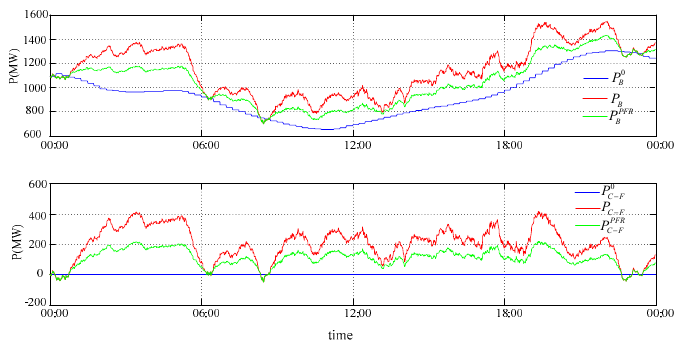
Figure 14. The basic power, and actual power with and without PFR of VSC station B and the C − F transmission